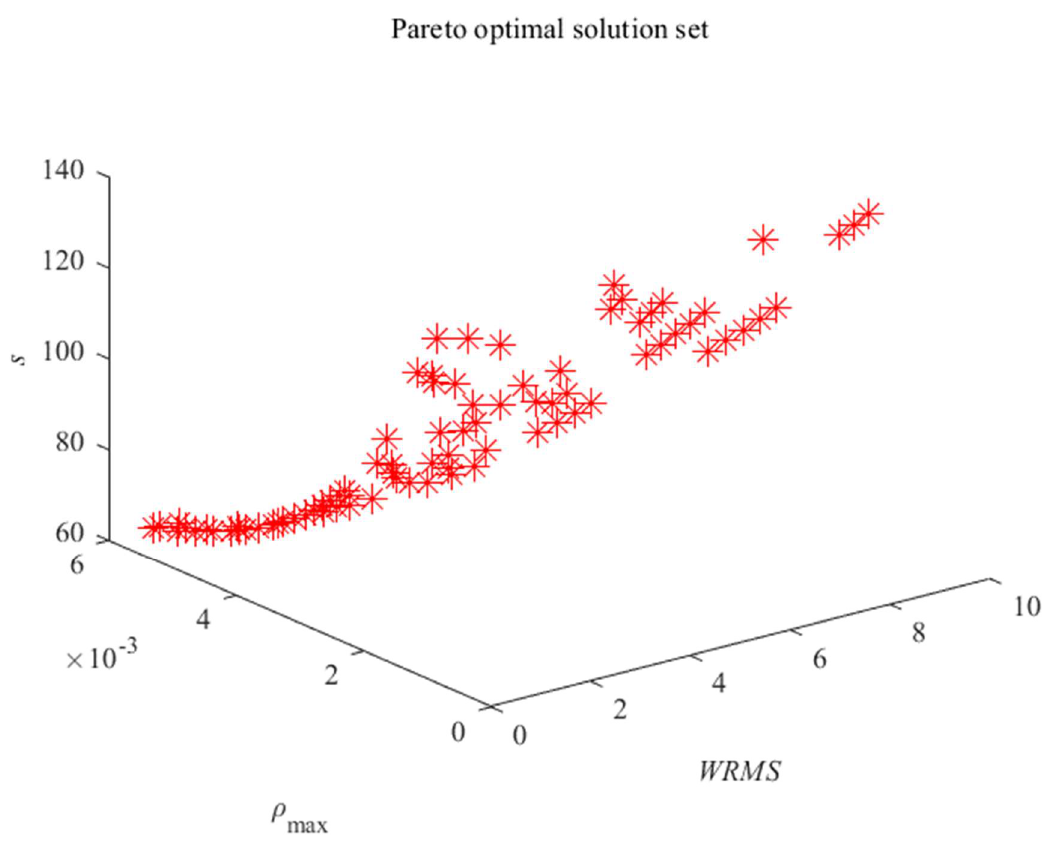
Figure 7. Pareto optimal solution set diagram.